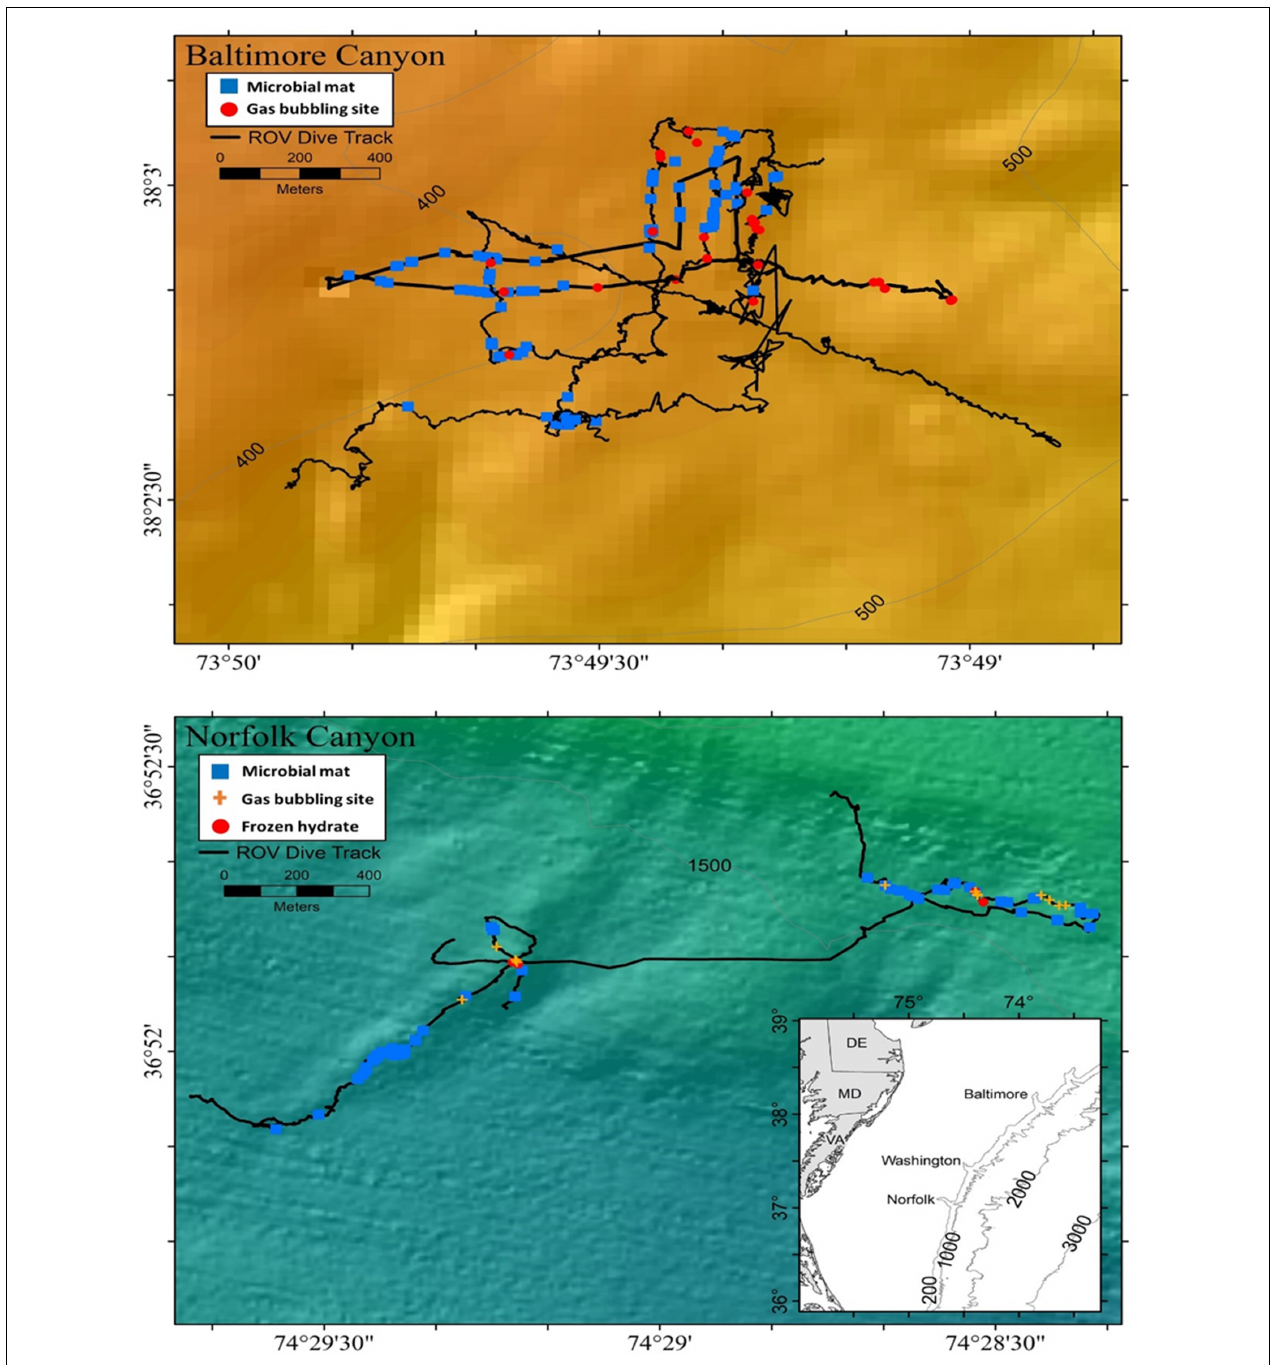
FIGURE 1 | Bathymetric maps (depth in meters) derived from multibeam sonar of Baltimore Canyon and Norfolk Canyon off the northeast United States coast, showing ROV (black lines) dives done in 2012 and 2013.